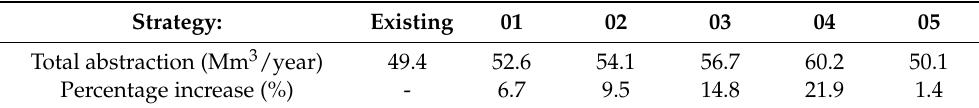
Table 1. Total optimal abstraction for the five identified strategies.